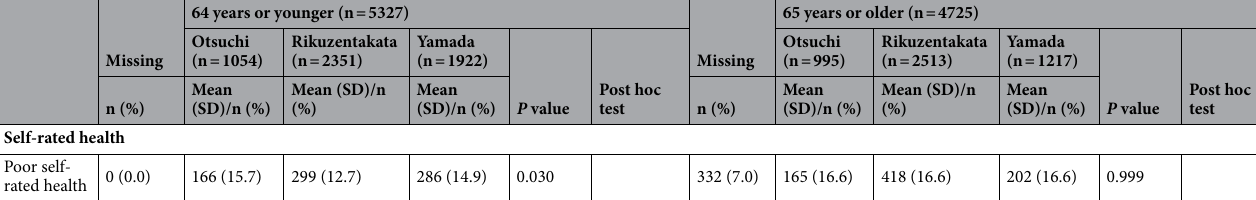
Table 1. Baseline characteristics of participants in the 2011 and survey (n = 10,052). Continuous variables are presented as means (standard deviations). Categorical variables are presented as the number of cases (%). P values were calculated using analysis of variance for continuous variables using Bonferroni correction, and the chi-squared test for categorical variables. SD standard deviation, IADL instrumental activities of daily living, PTSD post-traumatic stress disorder. *Statistically significant differences among municipalities. a Statistically significant difference between Otsuchi and Rikuzentakata. b Statistically significant difference between Rikuzentakata and Yamada. c Statistically significant difference between Yamada and